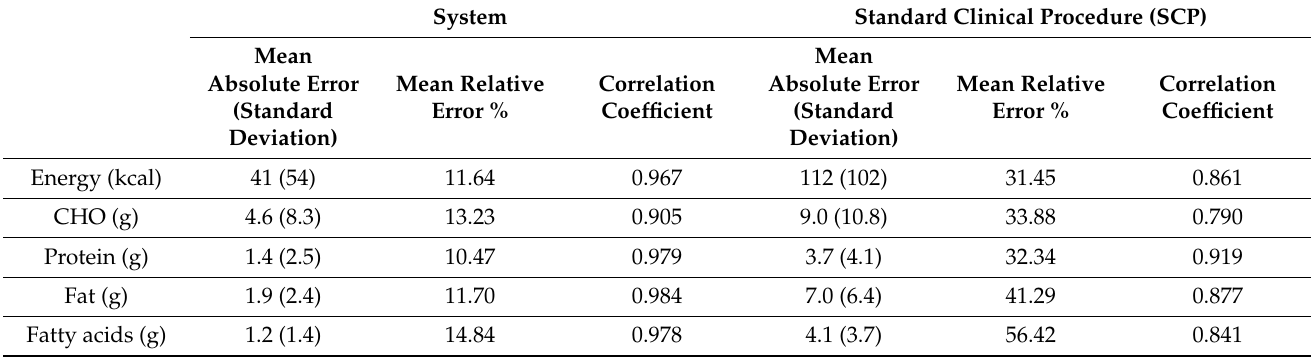
Figure 9. Differences in calories and macronutrient estimations per meal for the estimation methods. Difference was calculated by subtraction of the estimated calories or macronutrients of the system or the standard clinical procedure (SCP) from the visual estimation (reference) for each meal. Variation between the different estimations depicted as a box-plot in ( a ), where the circle and the square indicate the outliers, or as paired individual values in ( b ). The visual estimation is shown as a dotted line at a value of 0. Statistical analysis was performed using a paired- t -test. * = p ≤ 0.05. Table 3. Comparative results of the system and the nurse for the energy and the macronutrient intake for the testing set ( p <